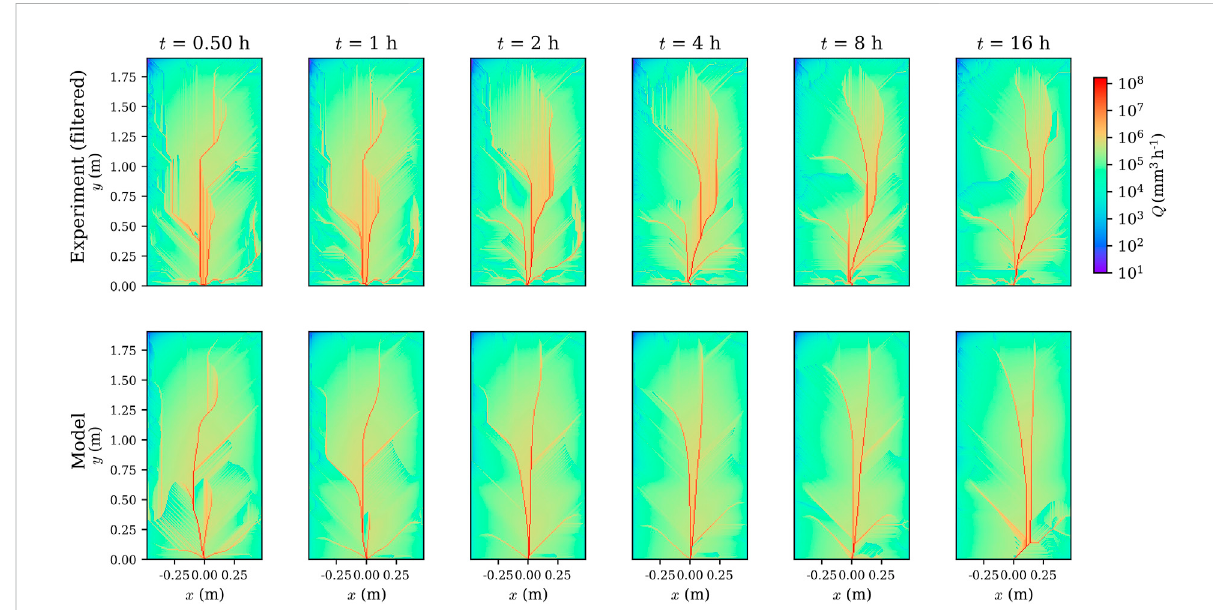
FIGURE 9 Discharge distribution at different times (logarithmic scale). The experimental network was calculated based on the fi ltered morphology.